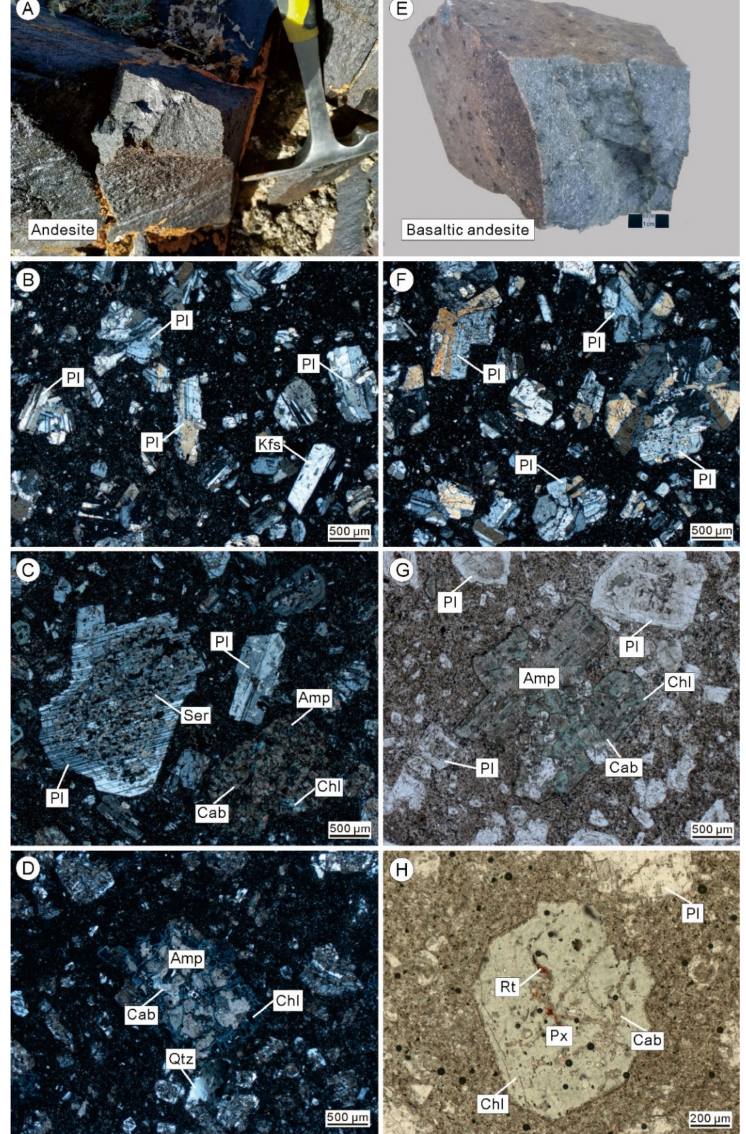
Figure 2. Hand-specimen and thin-section (micro)photographs of the Nageng ( A – D ) andesite and ( E – H ) basaltic andesite: ( A ) Andesite hand-specimen with phenocrysts of plagioclase and amphi- bole; ( B ) Major plagioclase and minor K-feldspar phenocrysts; ( C ) Sericite-altered plagioclase and carbonate-chlorite-altered amphibole phenocrysts; ( D ) Carbonate-chlorite-altered amphibole with sporadic quartz phenocrysts; ( E ) Basaltic andesite hand-specimen with phenocrysts of plagioclase and amphibole; ( F ) Plagioclase phenocrysts; ( G ) Carbonate-chlorite-altered amphibole phenocrysts; and, ( H ) Carbonate-chlorite-altered pyroxene phenocrysts with cracks filled with rutile. B – D , F : cross-polarized light; G , H : plane-polarized light. Abbreviations: Cab: Carbonate; Chl: Chlorite; Kfs: K-feldspar; Pl: Plagioclase; Px: Pyroxene; Qtz: Quartz; Amp: Amphibole; Ser: Sericite; Rt: